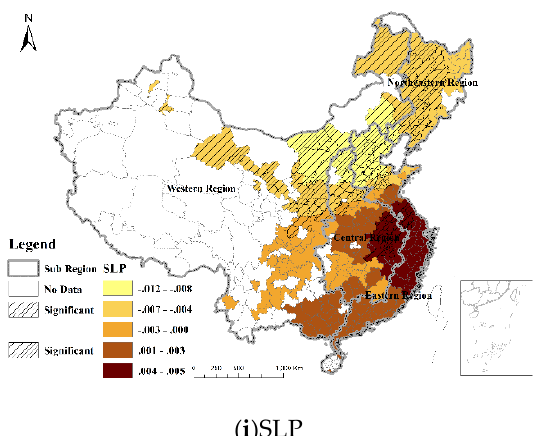
Figure 6. Spatial distribution of the regression coefficients for determinants based on a GWR model.